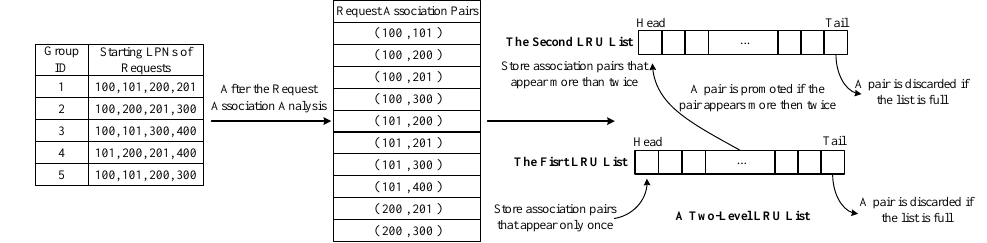
Figure 6. A two-level LRU list to maintain the hot association pairs. After the hot association pairs are selected, we can extract each request’s starting LPN from the hot association pairs and count the number of occurrences of each starting LPN in all association pairs. For example, Figure 7 shows the number of occurrences of each starting LPN in all association pairs such as (100,101), (100,200), (100,201), (101,200), (101,300), (200,201) and (200,400). Then, we can set a threshold to separate the strong requests according to the number of occurrences of each request’s starting LPN in all association pairs. As shown in Figure 7, assume that the threshold is 50%, the first 50% of all requests’ starting LPNs (sorted by the number of occurrences) are considered as strong requests (e.g., 200, 100 and 101) and are maintained in a strong request list. Other requests are considered as weak requests (e.g., 201, 300 and 400) and are maintained in a weak request list. Later, we will propose how to dynamically adjust the threshold (e.g., 50%) according to the current workload to improve the accuracy and performance in Section